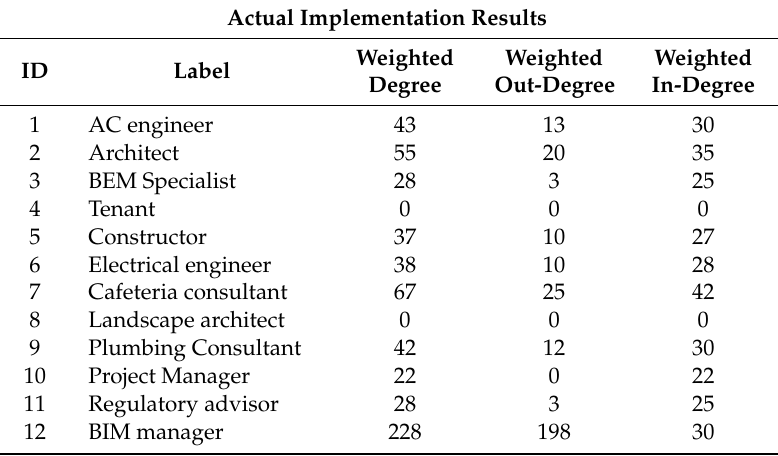
Table 1. SNA results for the actual implementation of BIM in green building.